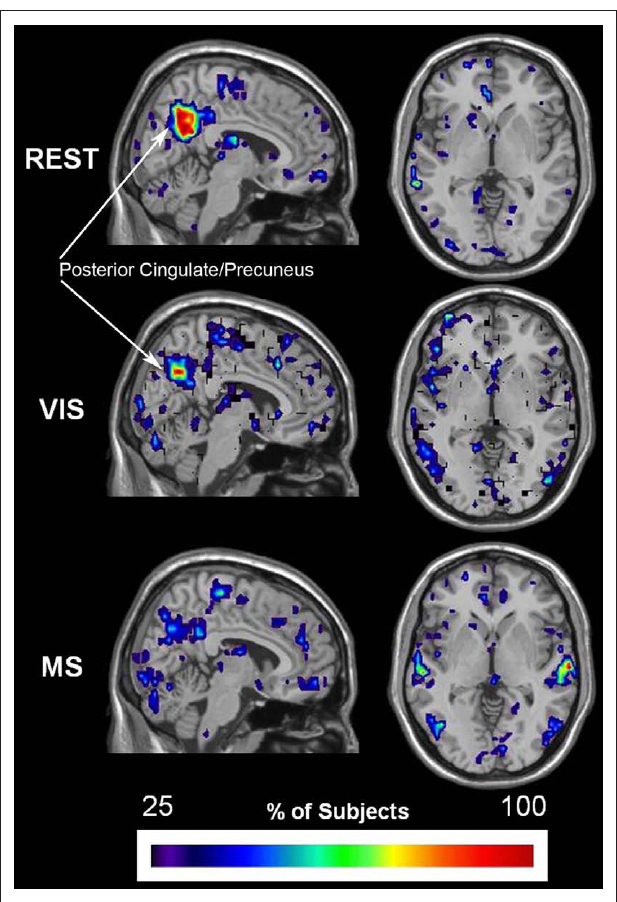
Figure 10 | Change in spatial distribution of provincial hubs across tasks. Individual participant provincial hub ( pk ≤ 0.01 and pc ≤ 0.3) maps were i i summated within each task to create an overlay image of spatial distribution within brain space. Note that the consistency of the provincial hubs is generally lower than the overlap presented in the preceding figures. However, there is a clear change in provincial node location across tasks. The rest (REST) condition shows with the greatest number and overlap of provincial hubs between participants in the precuneus, a brain region known to be part of the DMN. The number and overlap of provincial hubs in the visual and auditory cortices increases during the visual (VIS) and multisensory (MS) tasks. In addition, the precuneus loses provincial hubs during the sensory stimulation